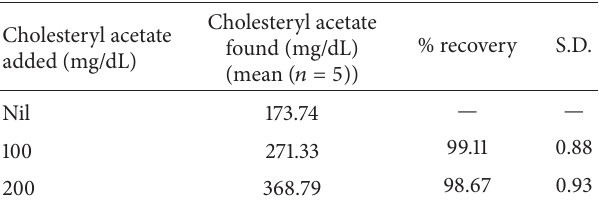
Table 1: Analytical recovery calculated by using added cholesteryl acetate in serum sample.